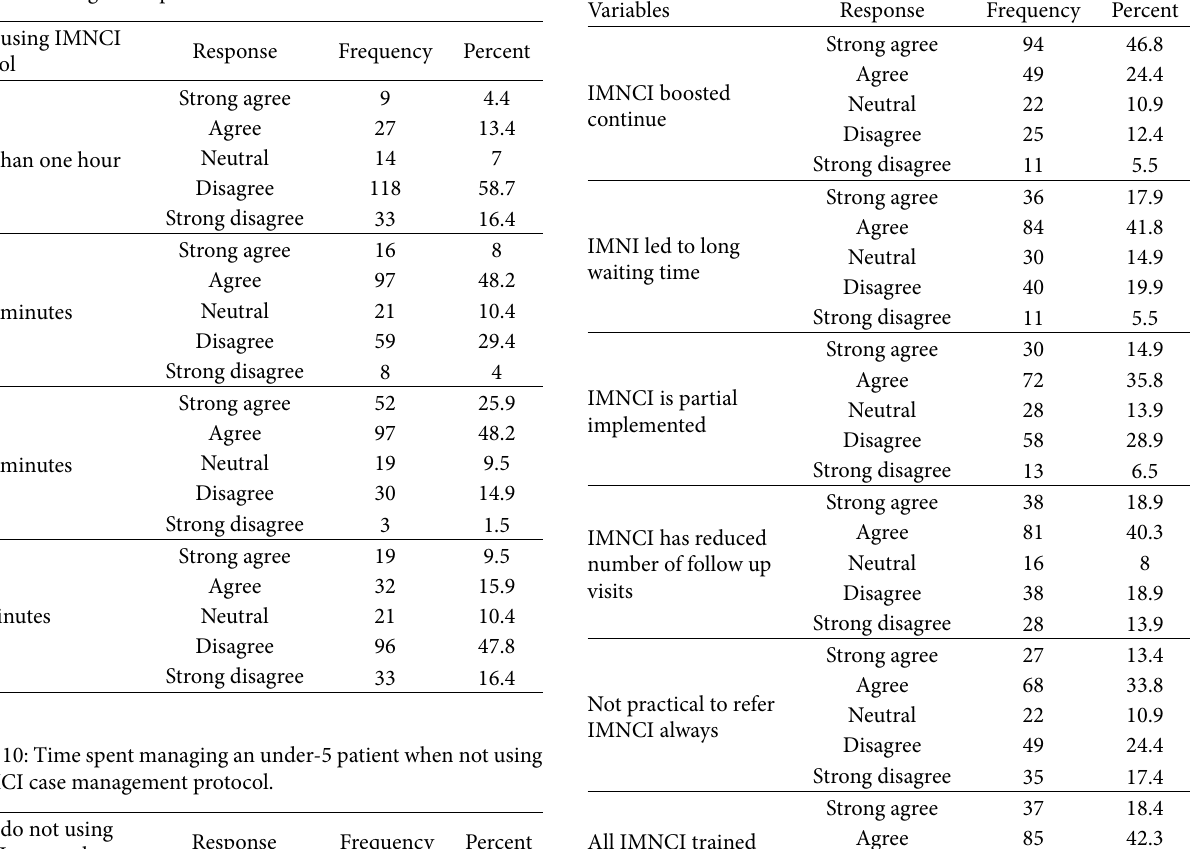
Table 9: Time spent managing an under-5 patient when using the IMCI case management protocol.